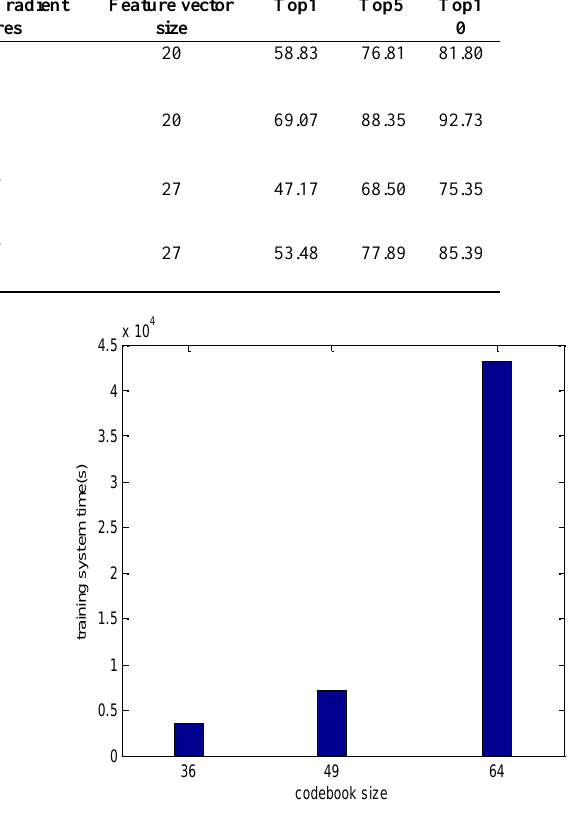
Figure8. Training system time for different codebook size.